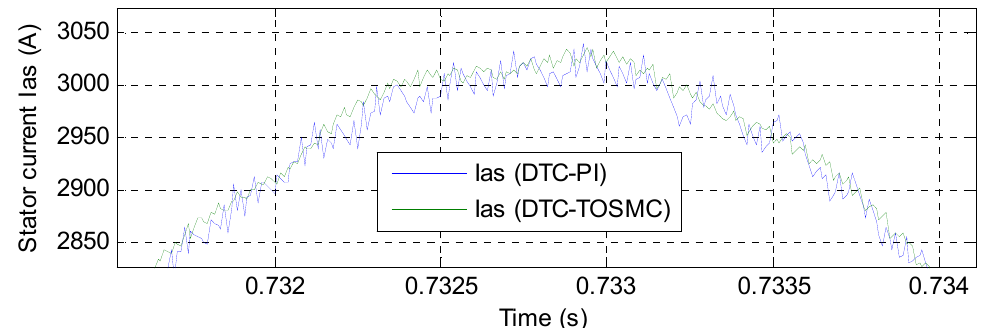
Figure 13. Zoom in the stator current.